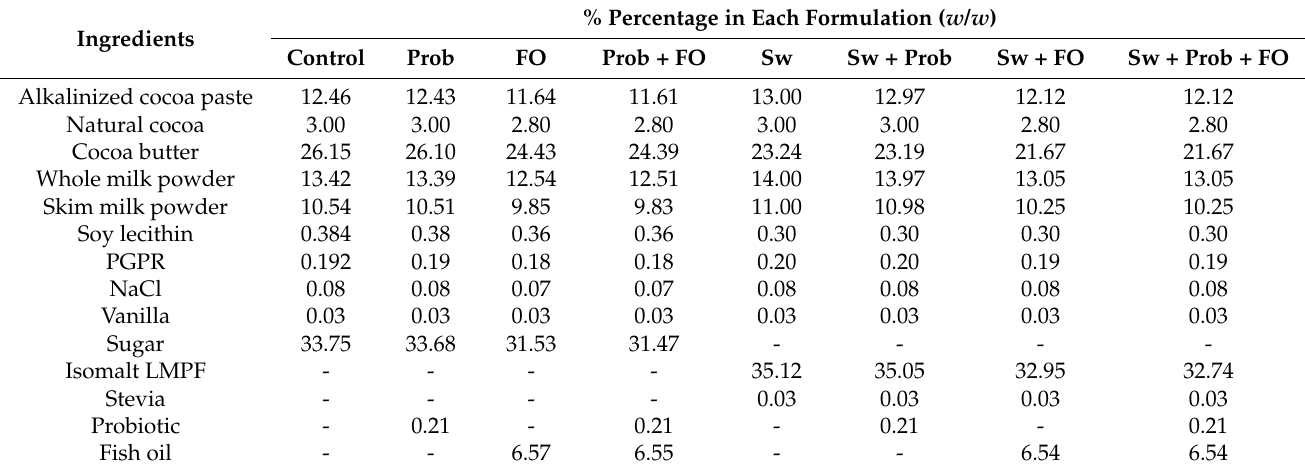
Table 1. Milk chocolate formulations added with probiotics and fish